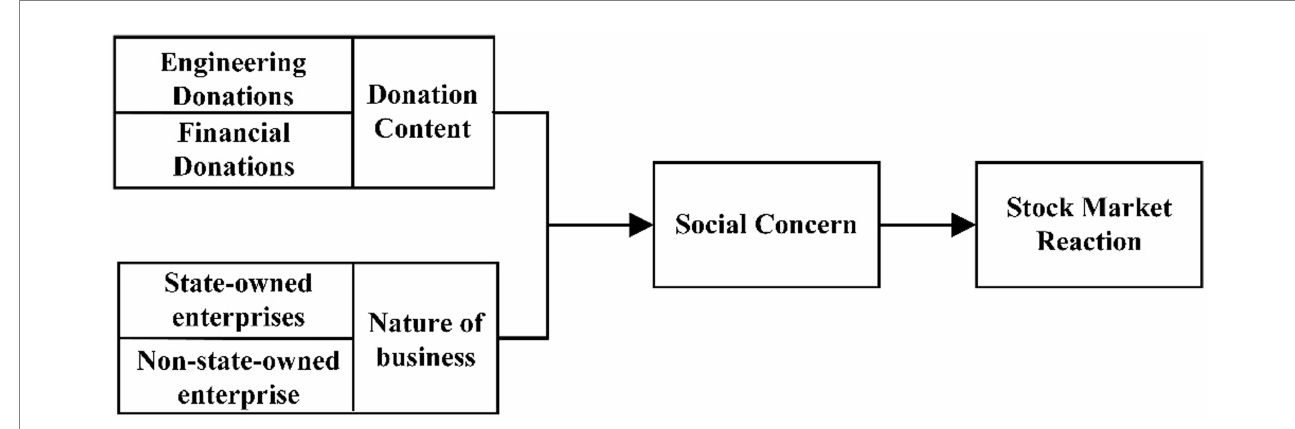
FIGURE 1 Mechanism of action between emergency donations and stock market